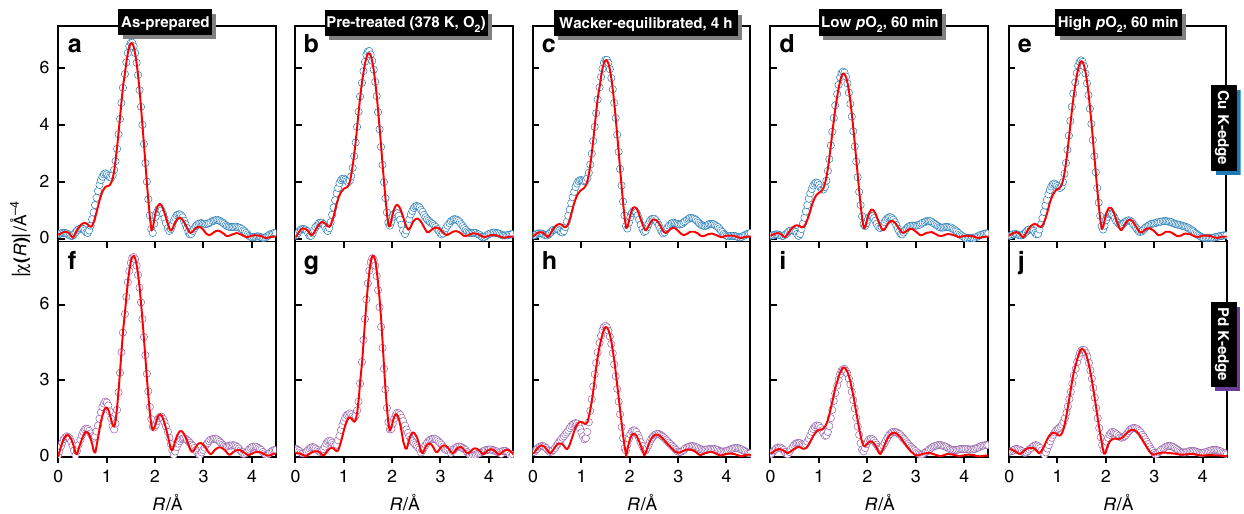
Fig. 3 In situ Cu and Pd K-edge EXAFS spectra. The k 3 -weighted Fourier transform magnitude (non-phase shift corrected) of the a – e Cu and f – j Pd K-edge EXAFS spectra of Pd1Cu5-Y before (as-prepared, pre-treated, Wacker-equilibrated) and at the end of each oxygen switching experiment, performed in the 3 – 11 Å -1 range (red traces: best fi t). The k 3 -weighted Cu and Pd K-edge EXAFS spectra are shown in Supplementary Fig.